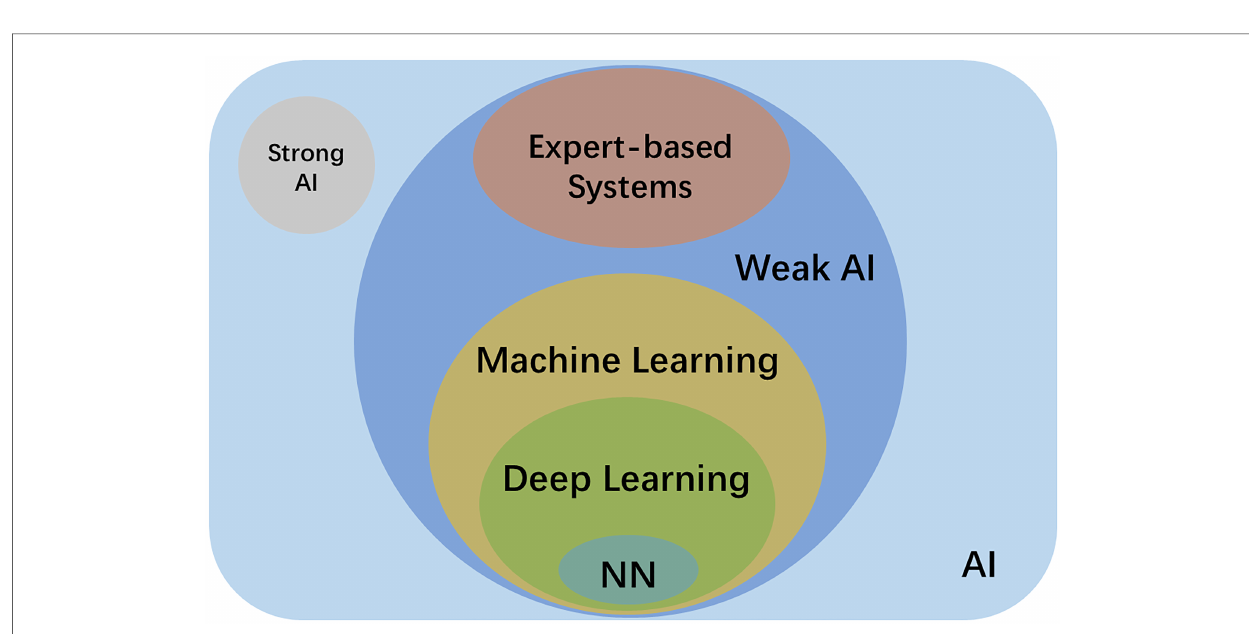
FIGURE 1 Schematic diagram of the relationship between AI, strong AI, weak AI, expert-based systems, machine learning, deep learning and neural network (NN).